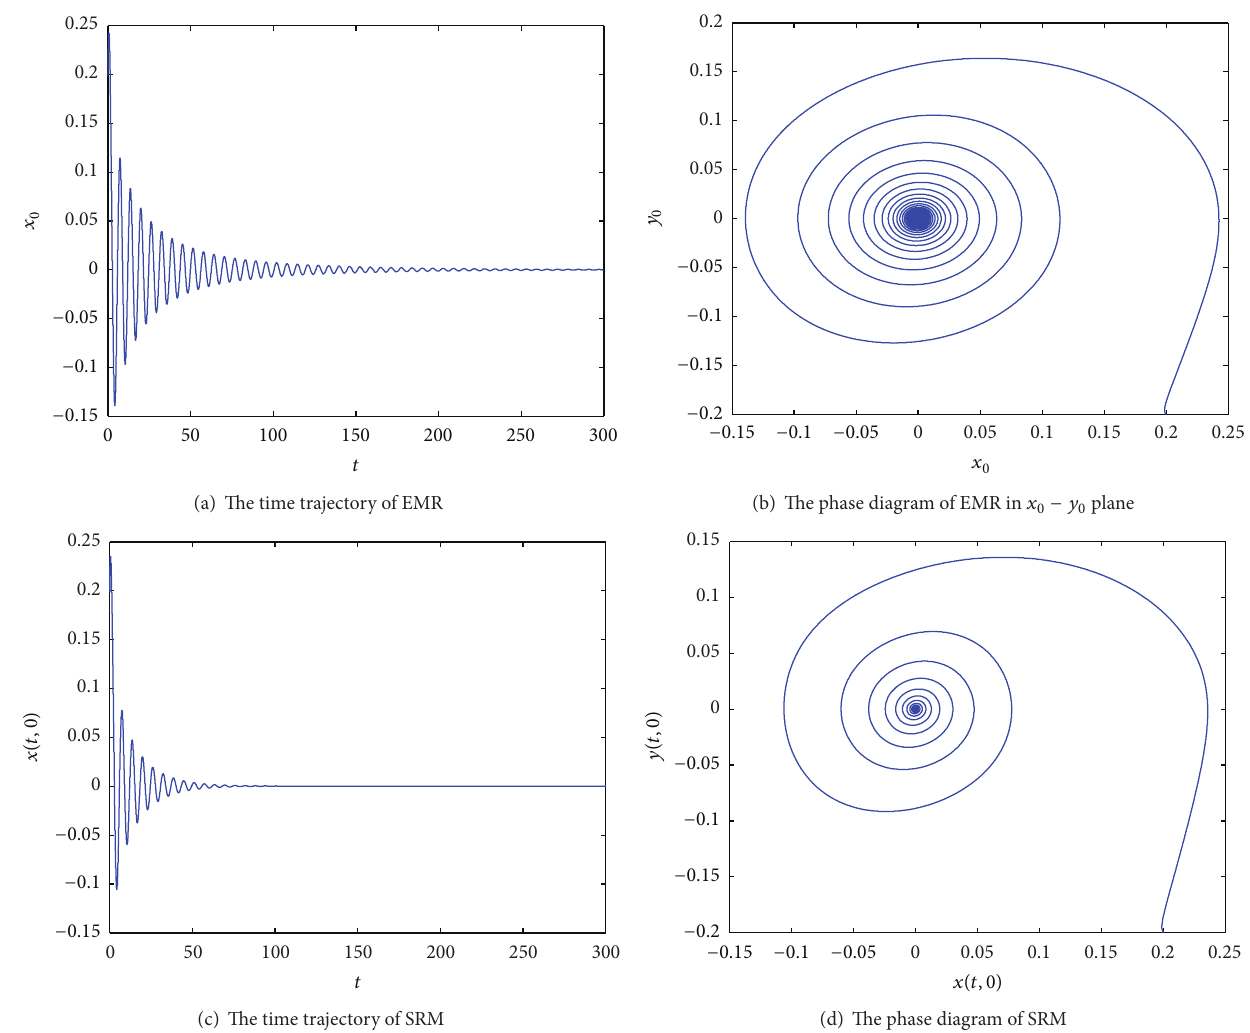
Figure 2: The time trajectories and phase diagrams for 𝑢 = −0.09